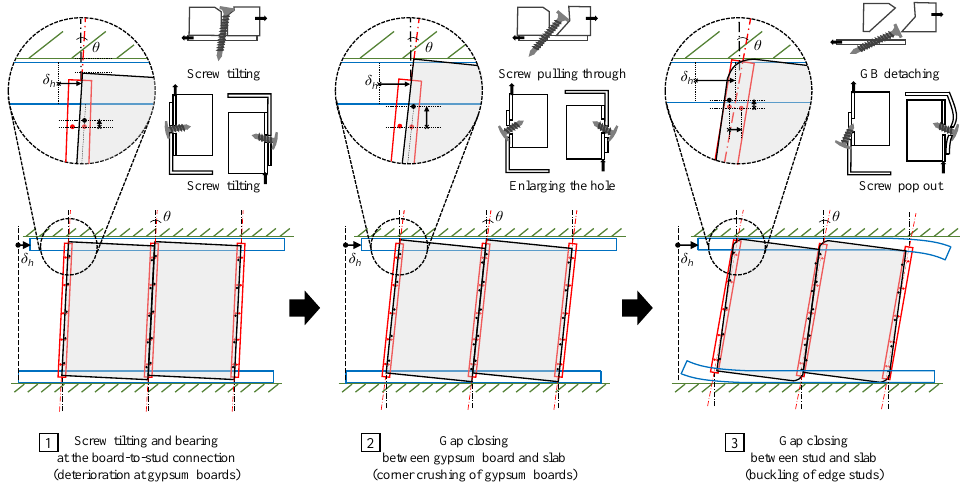
Figure 2. Damage mechanism of a typical CFS partition wall.